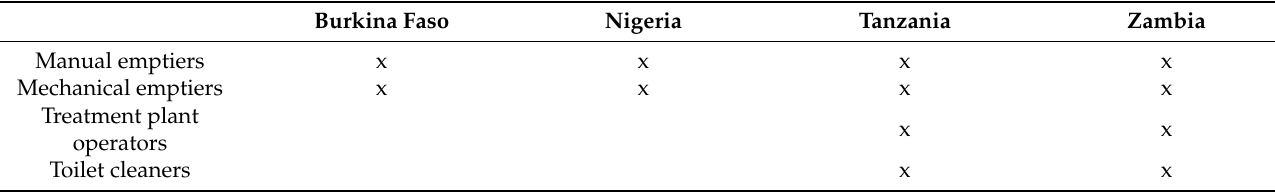
Table 1. Types of sanitation workers included in the methodology.